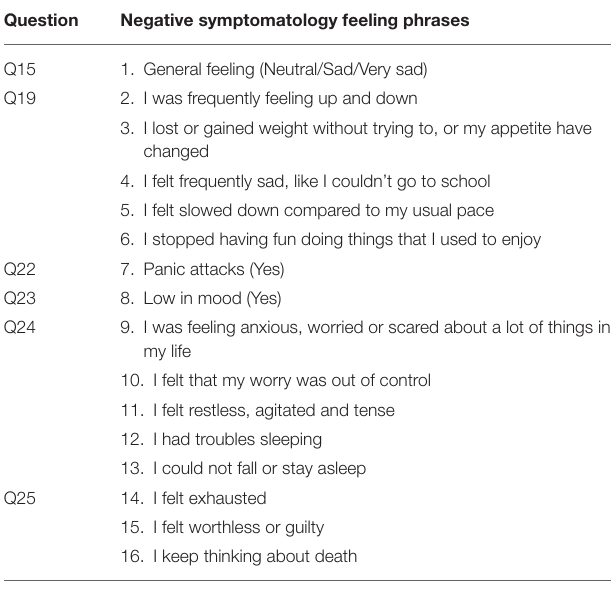
TABLE 1 | Questions addressing negative symptomatology in the study